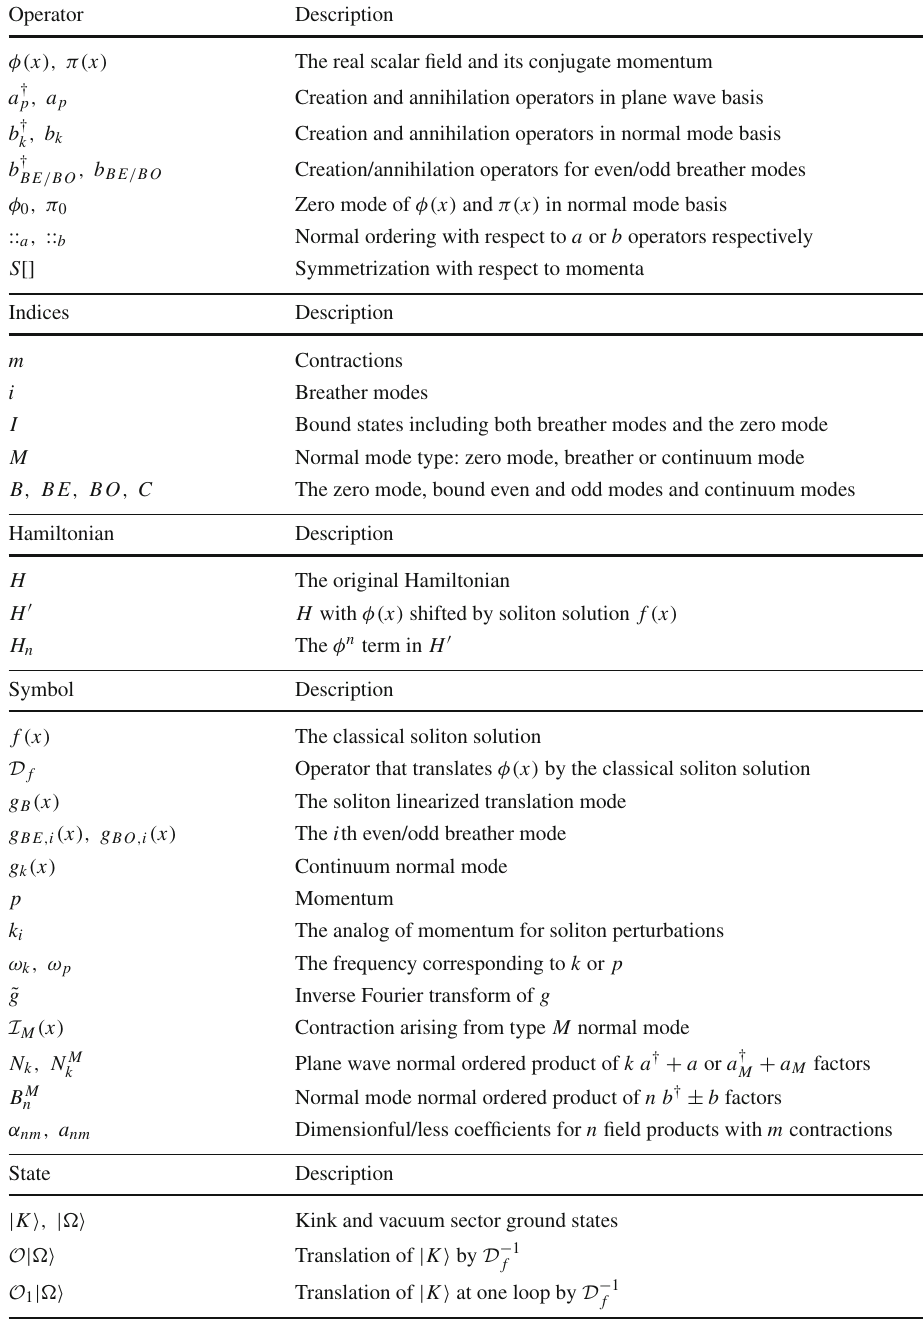
Table 1 Summary of